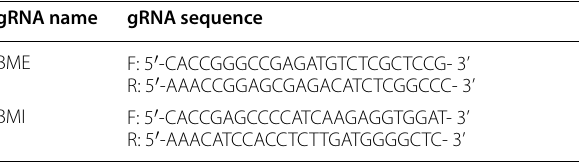
Table 1 The guide RNAs targeting the B2M gene gRNA